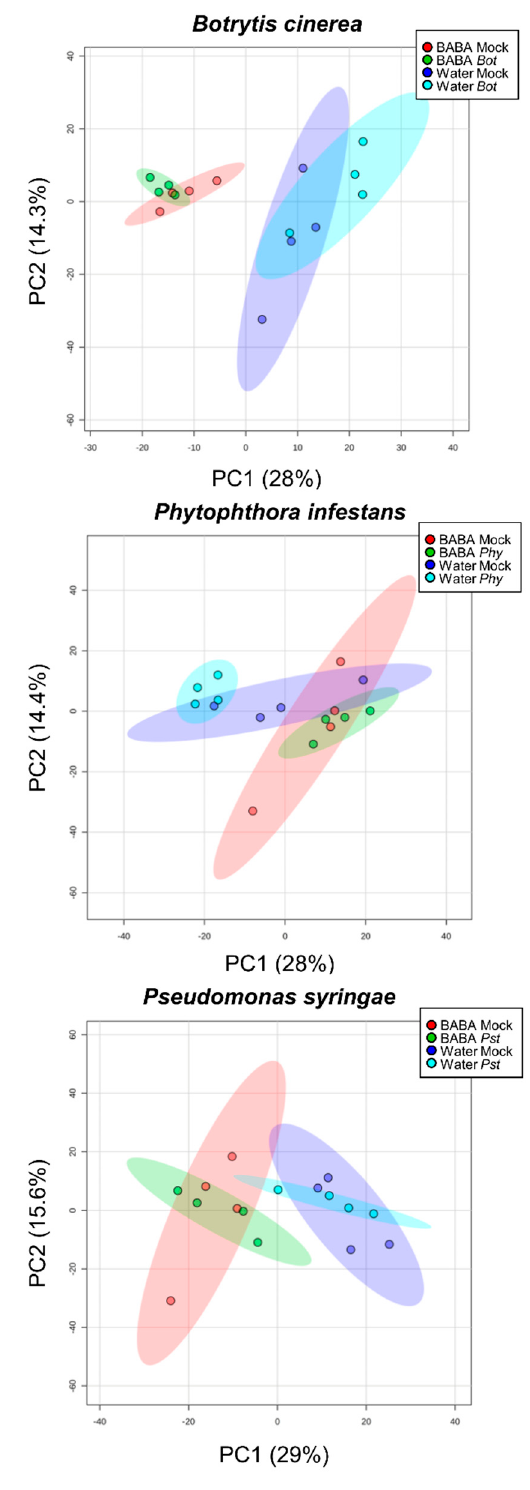
Figure 4. Partial segregation of pathogen inoculations for each fruit pathosystem. PCA score plots ( n = 4) of 6898 features (6887 electrospray ionisation orbitrap high-resolution mass spectrometry (LCMS) variables + 11 major compounds) showing metabolomics overview between the three di ff erent pathosystems. Maximal variance explained by each PC are given in